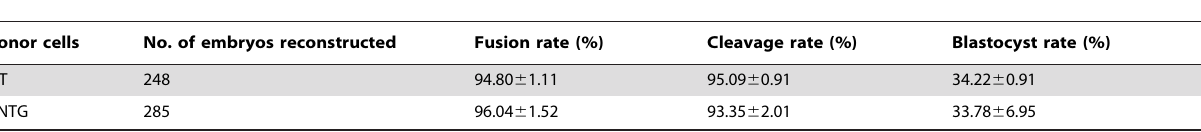
Table 2. Development of hIFN- a transgenic SCNT embryos and non-transgenic SCNT embryos.